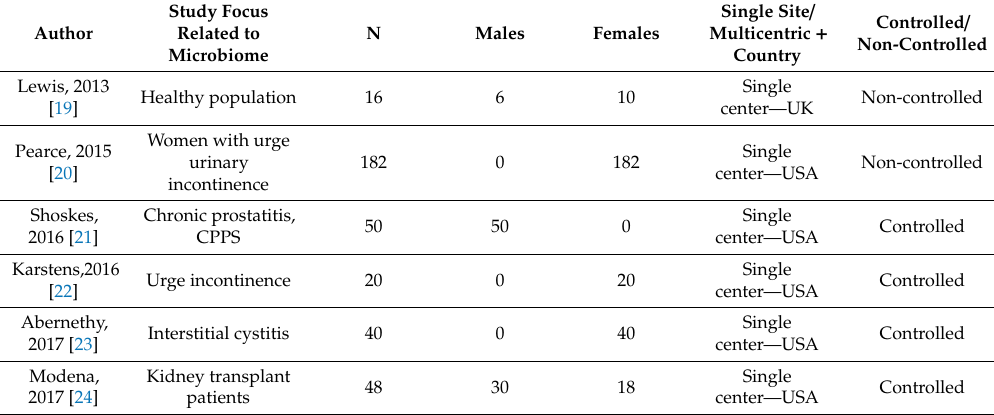
Table 2. Study design, settings, population included and study focus in relation with microbiome (CPPS—chronic pelvic pain syndrome, UTI—urinary tract infection, LUTS—lower urinary tract symptoms, HTN—arterial hypertension, AKI—acute kidney